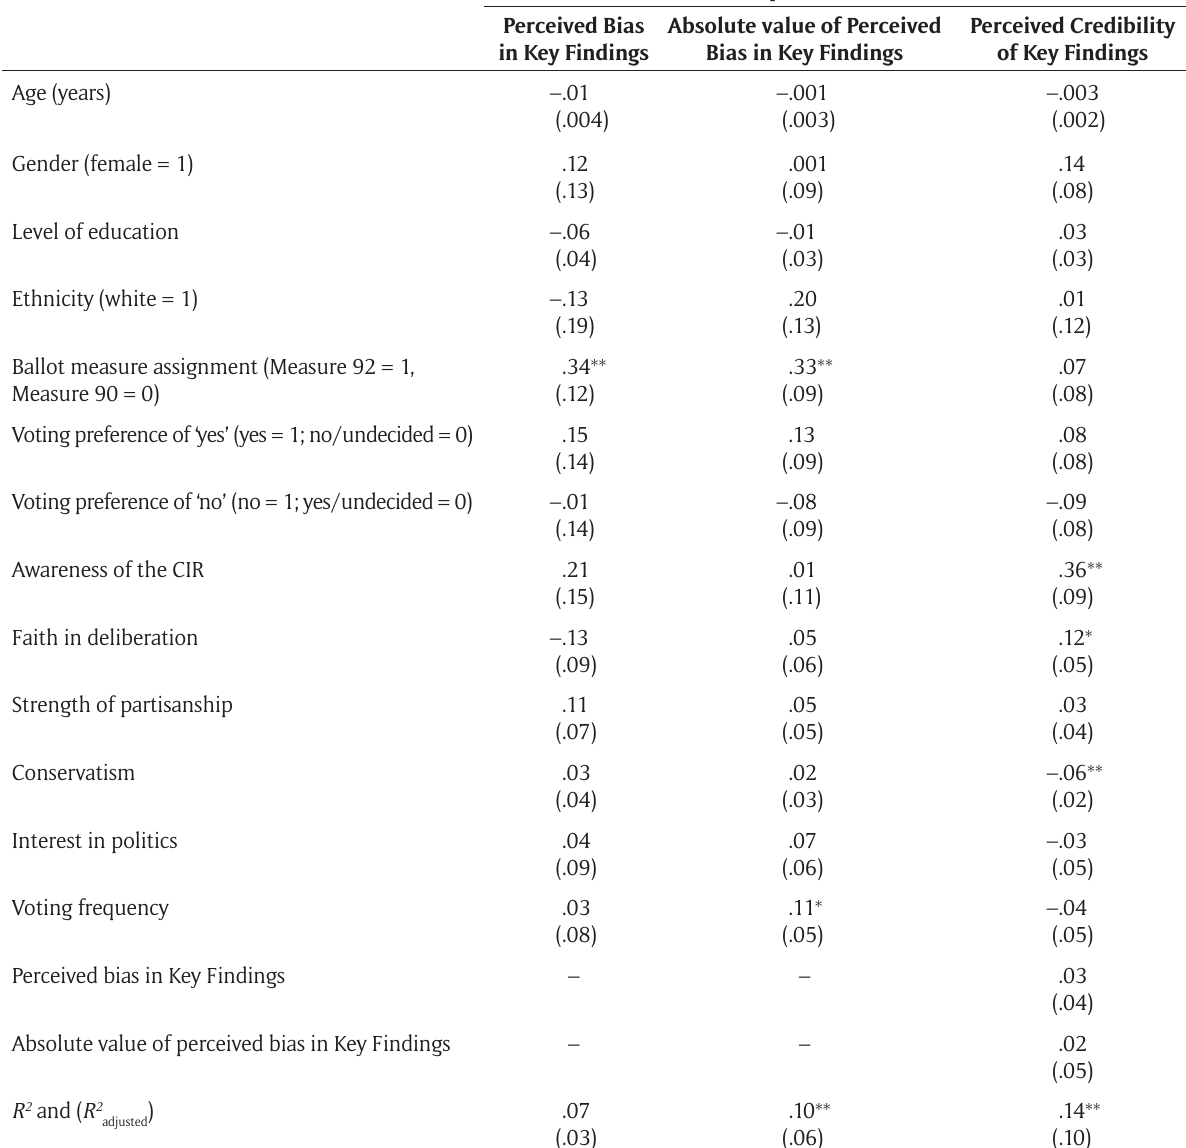
Table 5: Multiple Linear Regression Analyses for Perceived Bias and the Credibility of Key